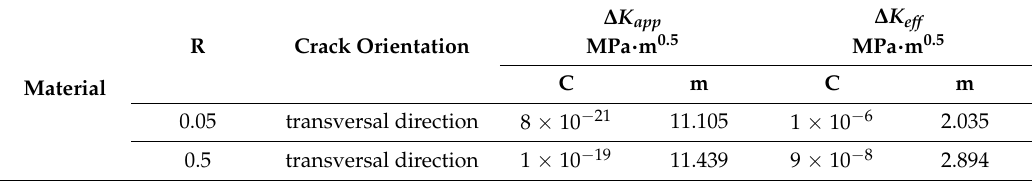
Figure 13. Representative fatigue fracture surface of the broken specimen tested under mode I condition (R = 0.5)—approximately 6 mm from notch.